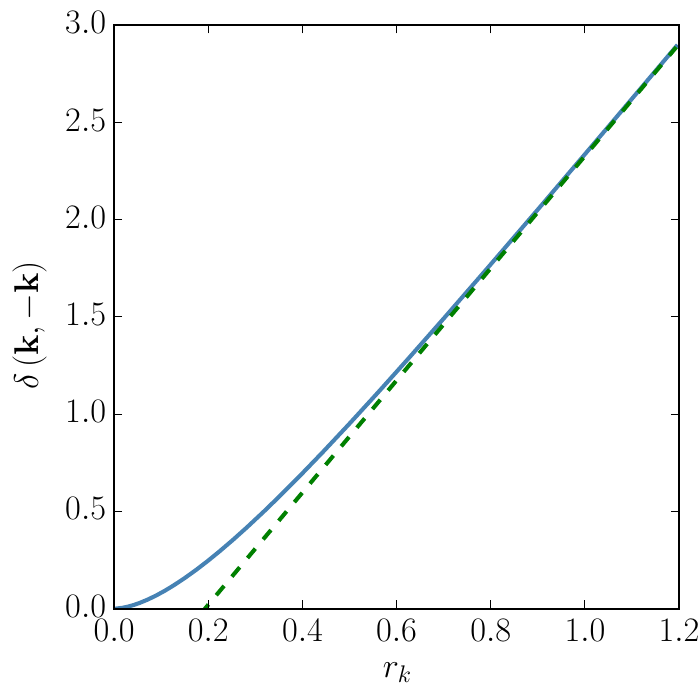
Figure 2. Quantum discord of a two-mode squeezed state as a function of the squeezing parameter r k (solid blue line). The dashed green line represents the large r k expansion of δ ( k , from Ref.